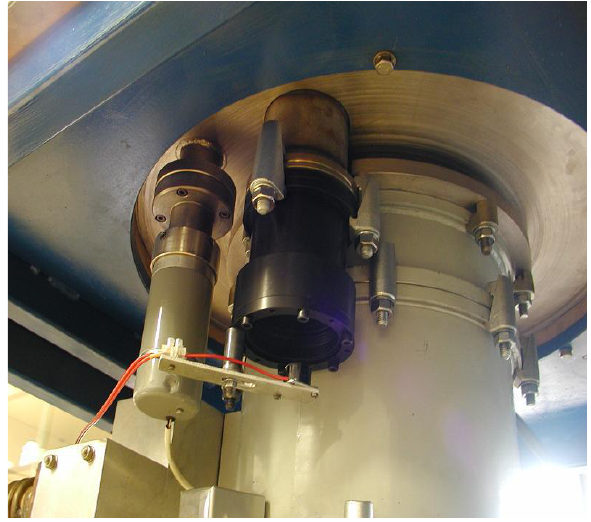
Fig. 2. Example of a vacuum port with a simplest holder for illuminating system with LED and associated optics